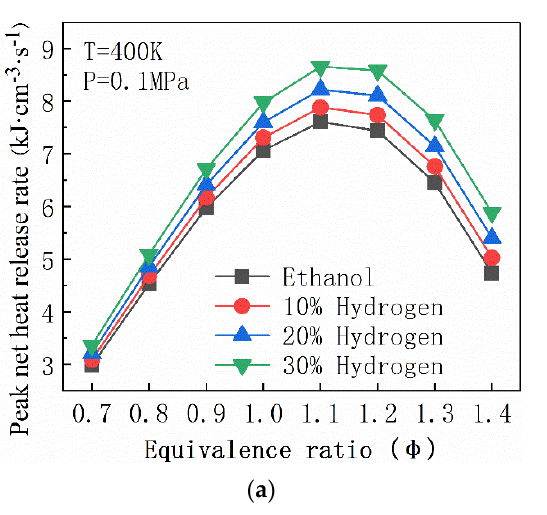
Figure 10. The peak NHRRs and HRR0 of ethanol − hydrogen − air flames with various hydrogen concentrations and φ . ( a ) Peak net heat release rate (NHRRs). ( b ) Heat release rate